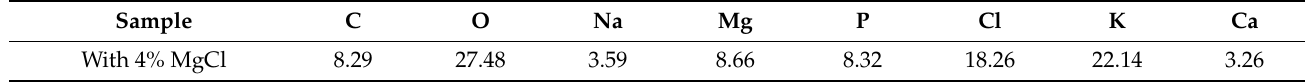
Figure 11. EDS of samples with 4% MgCl cured for 28 days. Table 4. The element distribution obtained by EDS.